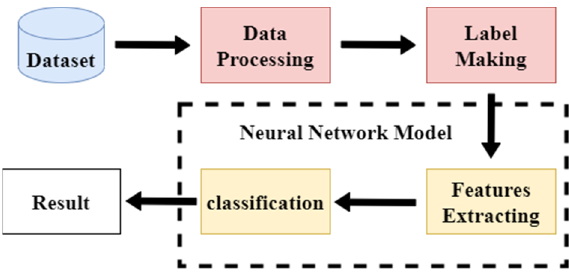
Figure 2. The single model classification process.